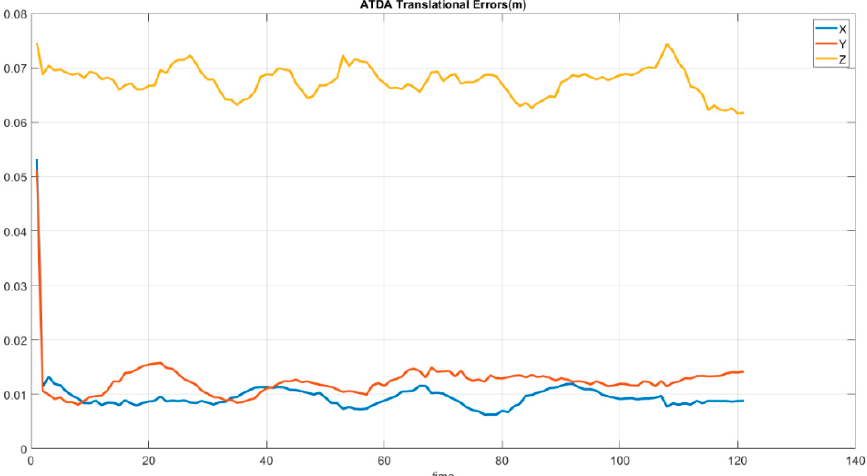
Figure 19. ATDA base Stewart platform translational estimation error along the X (blue), Y (red), and Z (yellow) axes.